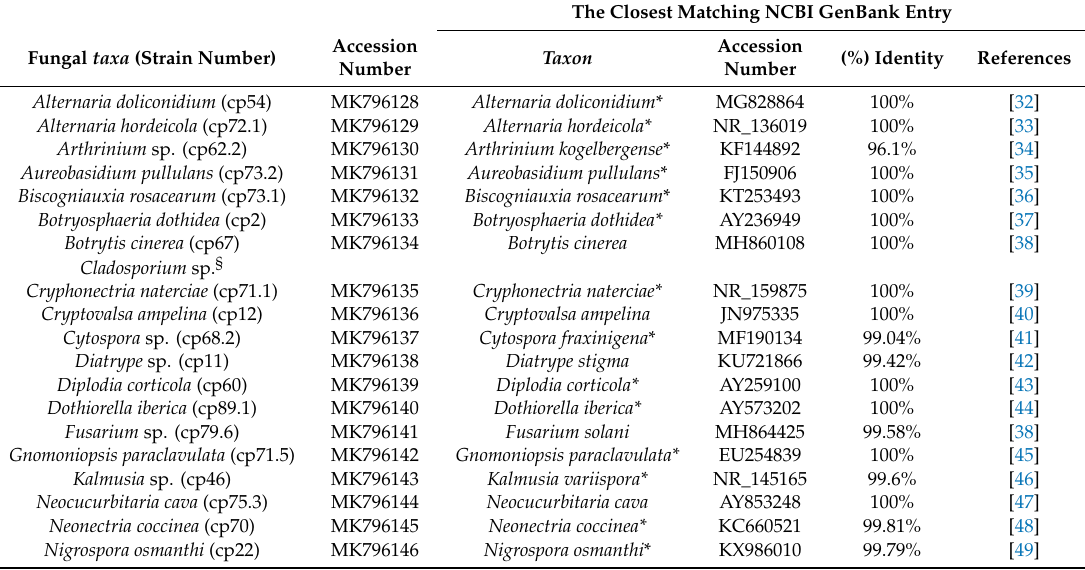
Table 3. Percentage of internal transcribed spacer (ITS) sequence identity between representative isolates of each species obtained in this study and their closest matching references in GenBank. The Closest Matching NCBI GenBank